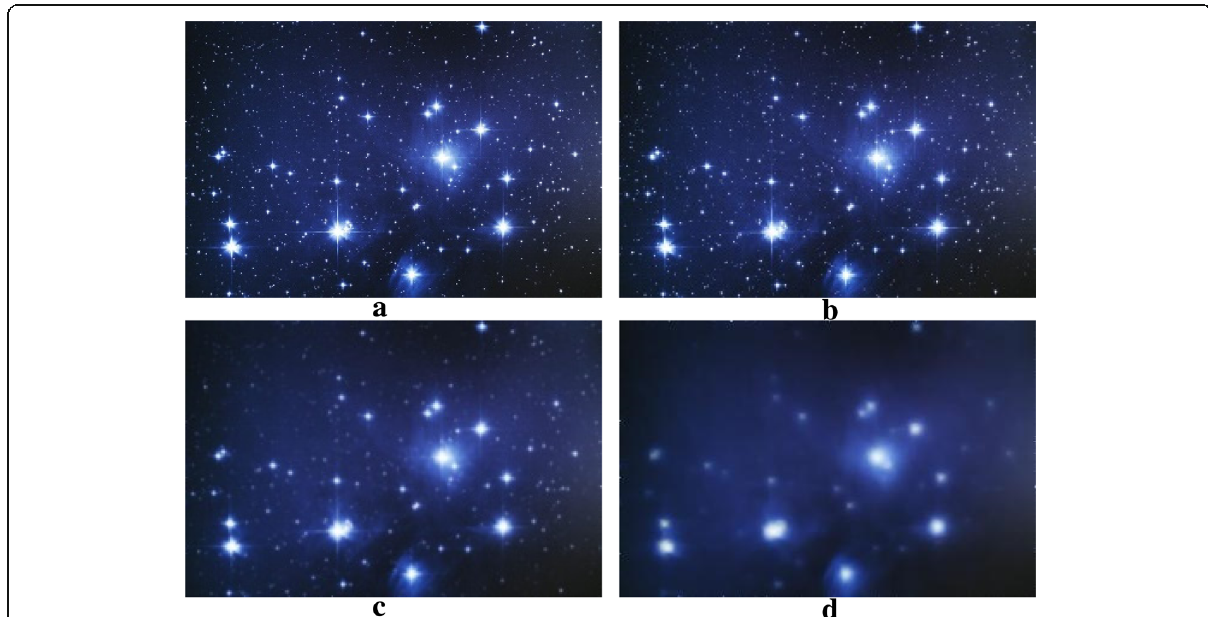
Fig. 8 Robust smoothing of color Pleiades image for n = 5. a Original image, b RF ( λ = 0.25), c AMD ( λ = 0.25), and d FORADF ( λ = 1). λ represents the control parameter, and n represents the number of iterations. The results are given to demonstrate the superiority in robustness of the proposed FORADF in comparison with other robust